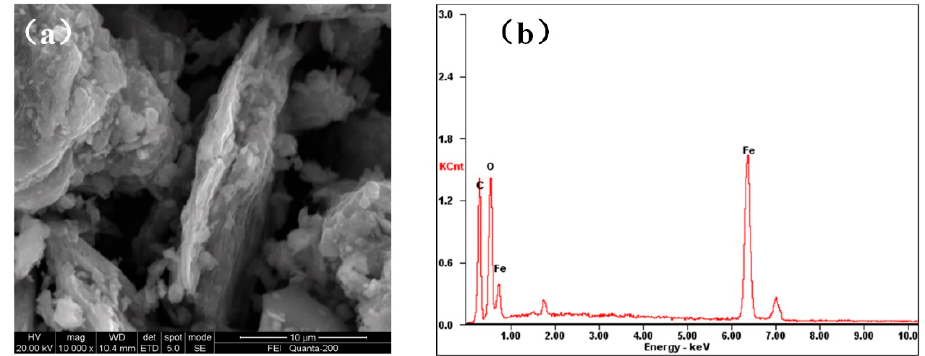
Figure 1. Characterization of magnetic graphene oxide (MGO): ( a ) SEM image; ( b ) EDS analysis.